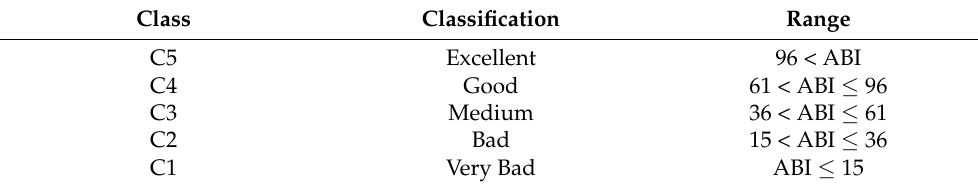
Table 5. Water quality classification according to the ABI value